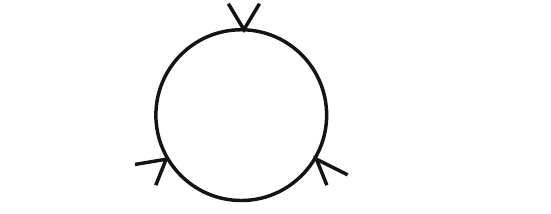
Fig. 2 The leading contribution to the three-particle coupling constant of the effective theory